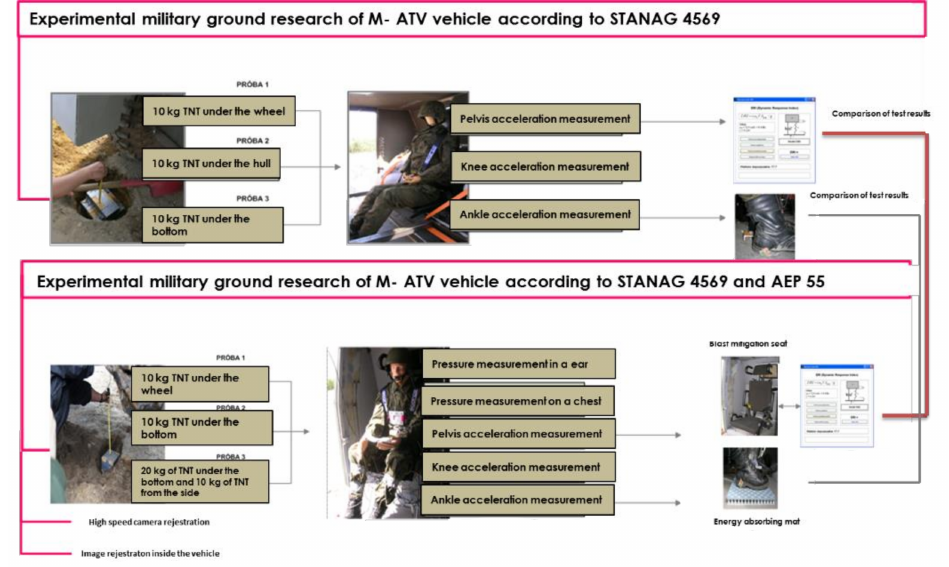
Figure 3. Overview of the experimental research.